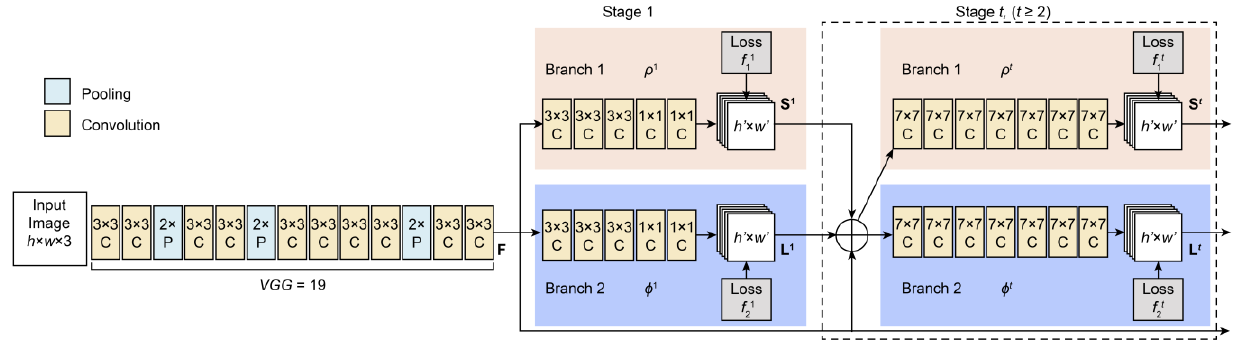
Figure 14. Multiperson pose estimation model architecture for OpenPose. Source: https://learnopencv.com/multi-person-pose-estimation-in-opencv-using-openpose/ (access date: 1 October 2022).